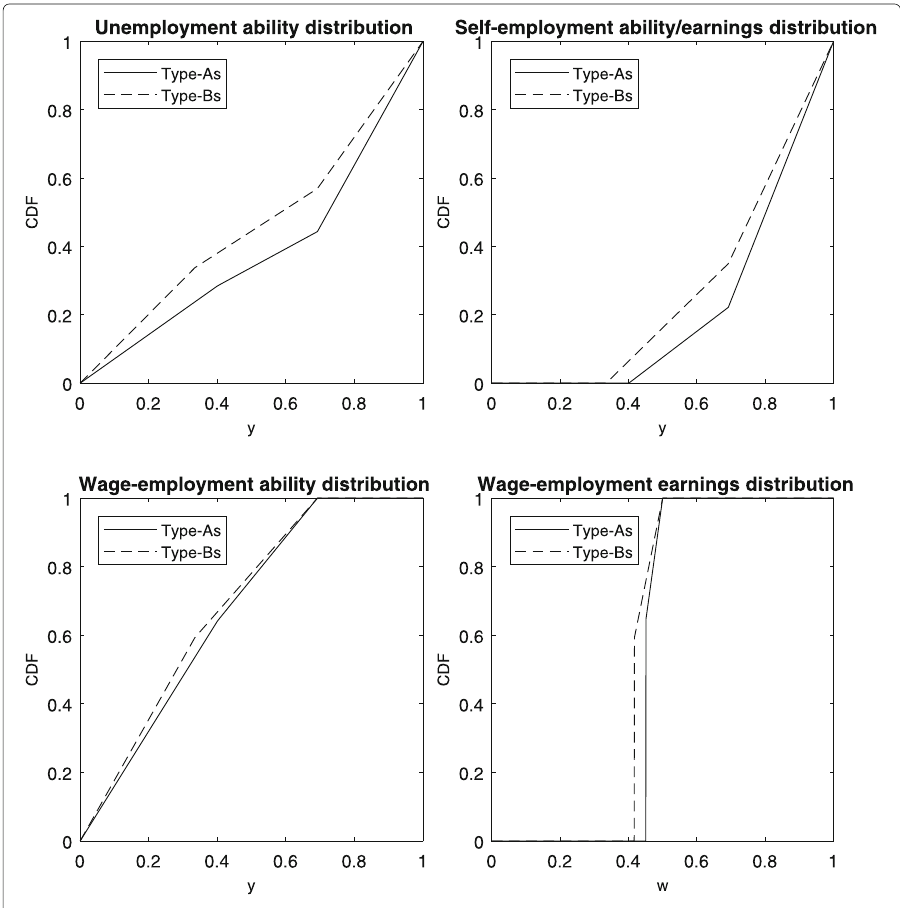
Fig. 3 Ability and earnings in the baseline model with discrimination